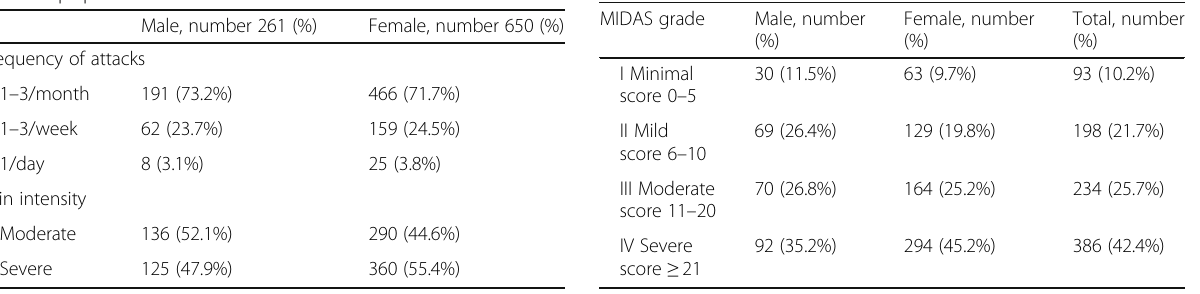
Table 2 Features of migraine attacks among the studied population Table 3 MIDAS grading in patients with migraine